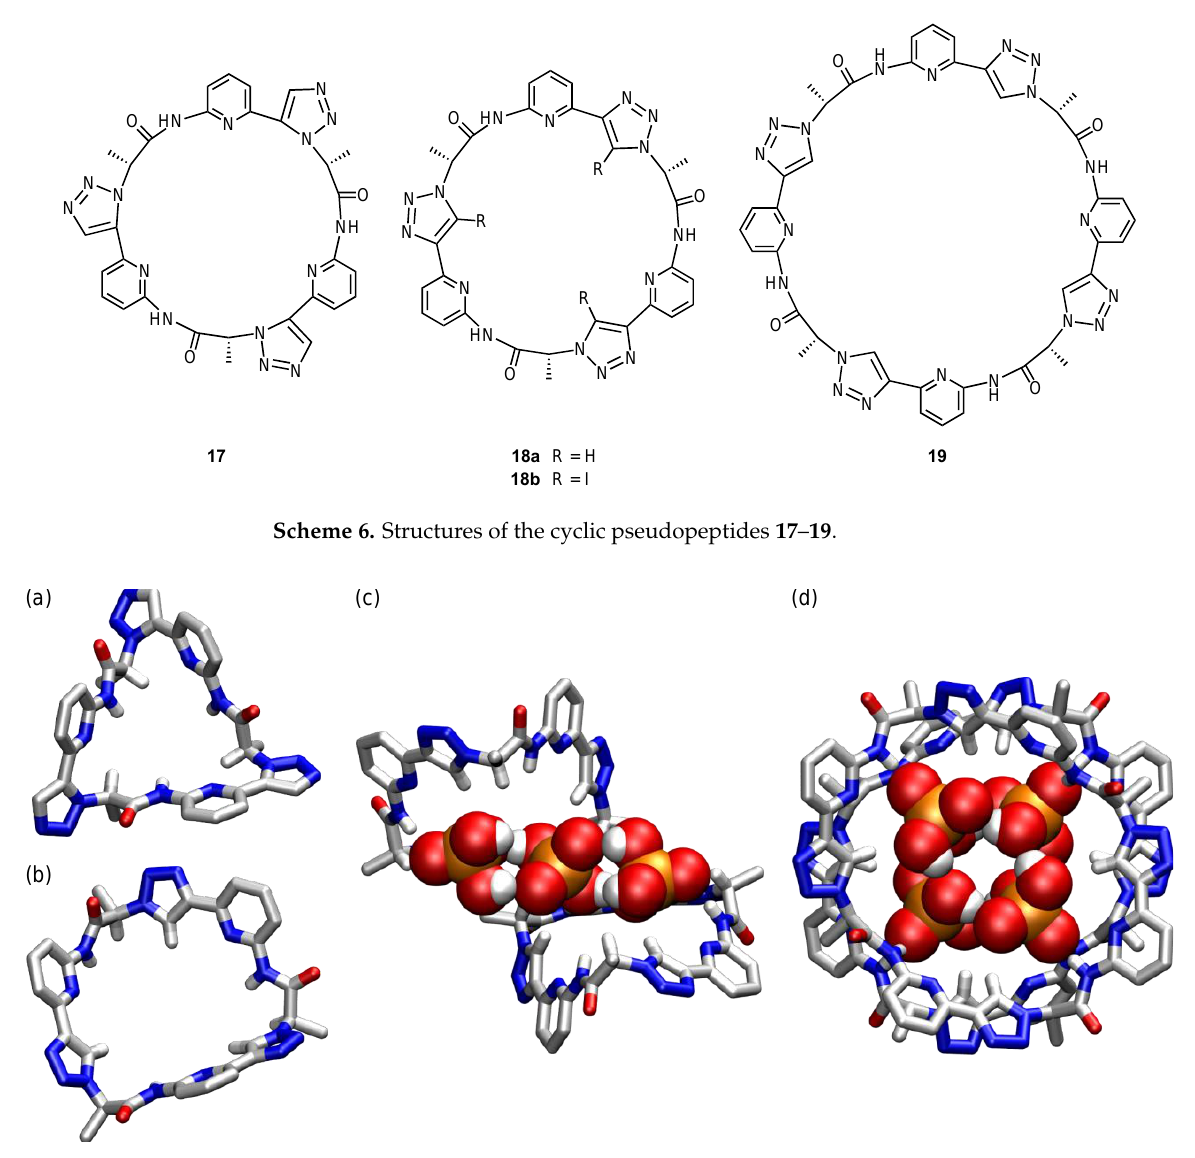
Figure 10. Crystal structures of 17 (CSD Entry: HADVIT) ( a ), 18a (CSD Entry: EYUKUG) ( b ), the 2:3 dihydrogenphosphate complex of 18a (CSD Entry: EYUTEZ) ( c ), and the 2:4 dihydrogenphosphate complex of 19 (CSD Entry: XAZQAT) ( d ). Solvent molecules, counterions, and protons, except acidic ones, and the H(α) and the triazole H(5) protons in ( b – d ) are omitted for reasons of clarity.